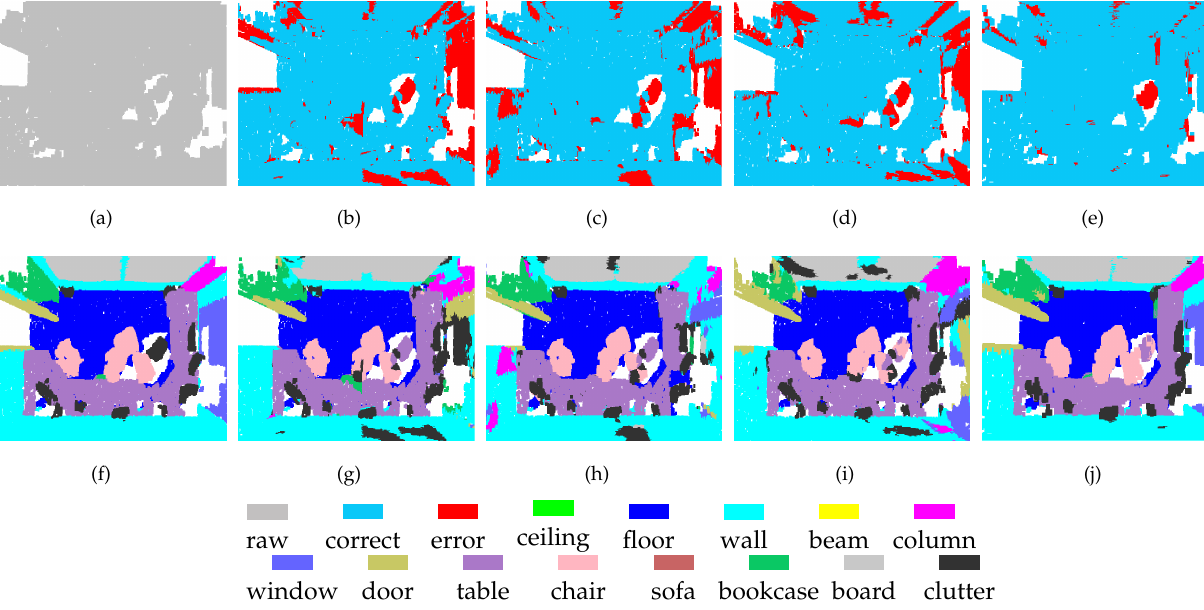
Figure 5. Segmentation results on the S3DIS-2 dataset: ( a ) input, ( f ) ground truth, ( b , g ) PointNet++, ( c , h ) PointSIFT, ( d , i ) SAN, and ( e , j )